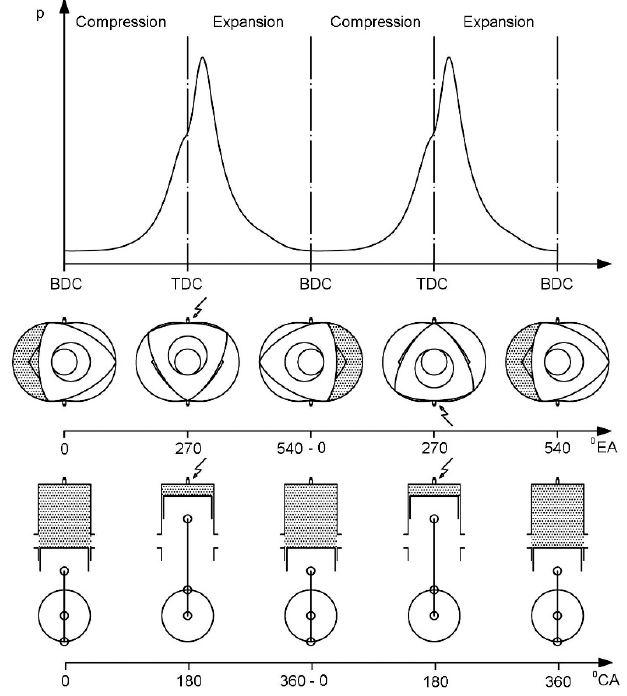
Figure 2. Two-stroke cycle for reciprocating and Wankel engines.